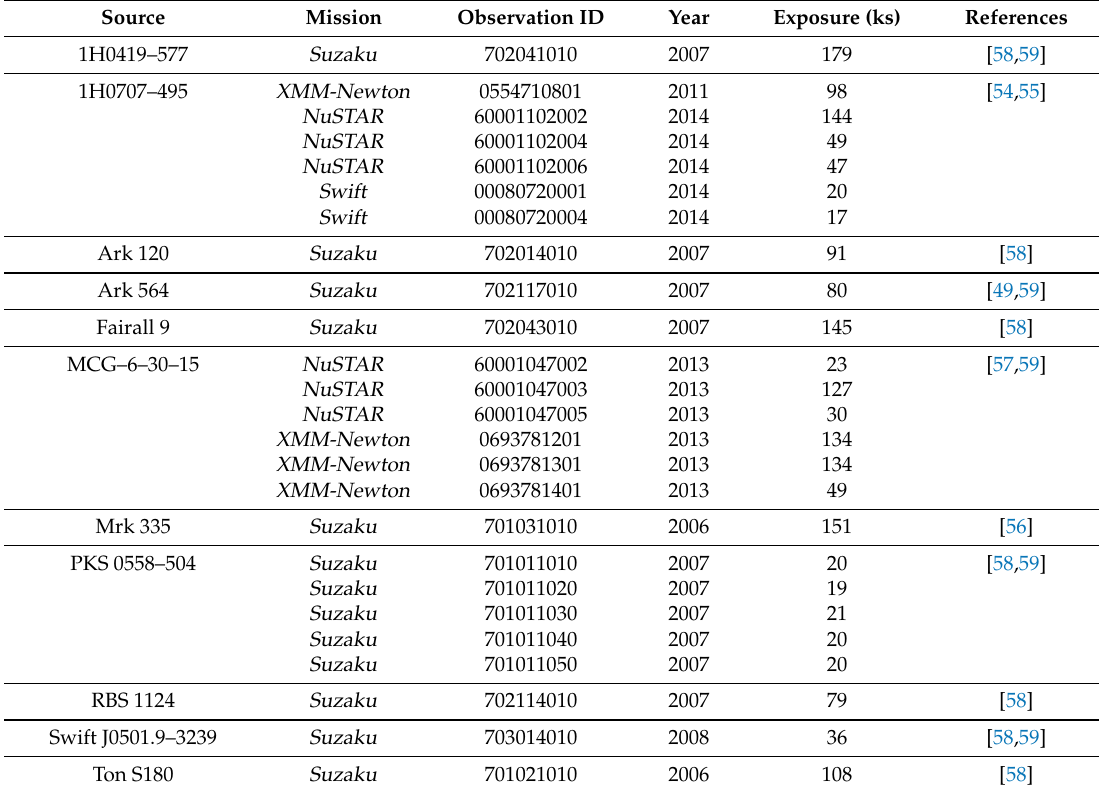
Table 1. List of the sources and of the observations analyzed as of now with RELXILL _ NK to test the Kerr nature of the associated supermassive black